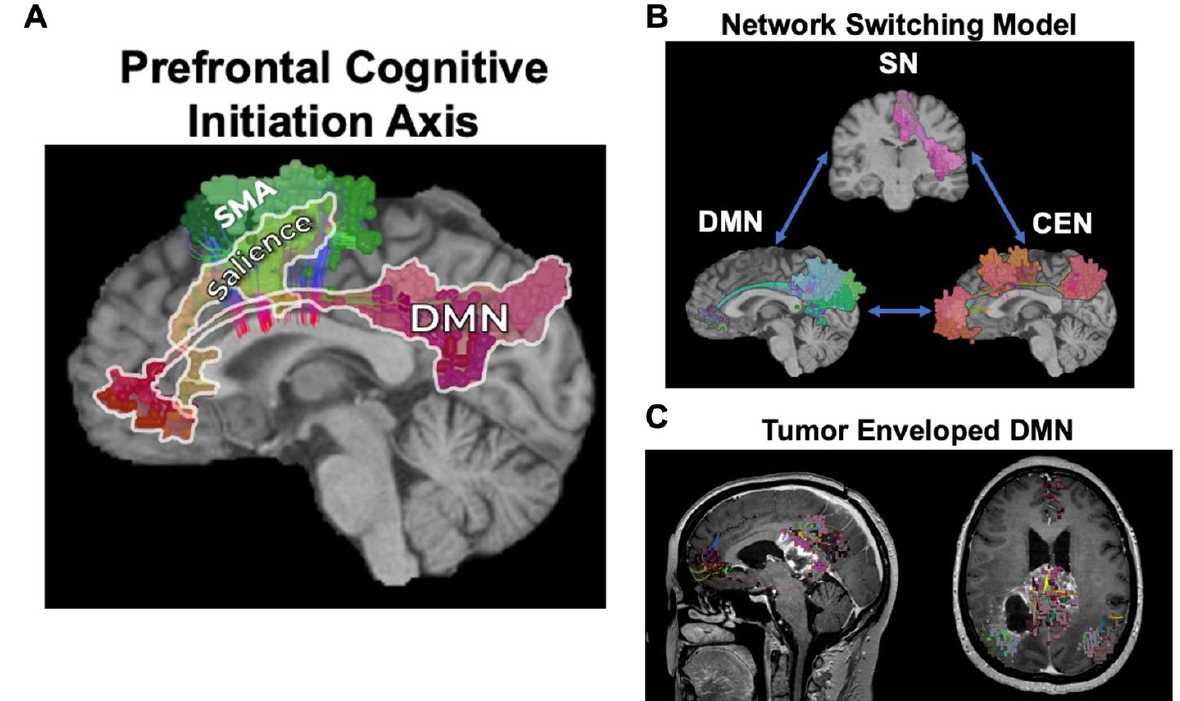
Figure 5. Prefrontal Cognitive Control Networks. ( A ) The Prefrontal Cognitive Initiation “Axis” is demonstrated where the DMN, connected via the cingulum, and the SN, connected via the frontal aslant tract, form a strip across the medial frontal lobe up until the supplementary motor area (SMA). ( B ) The network switching model, or triple network, is represented. The salience network (SN) controls the allocation of cognitive resources between internally focused (DMN) and externally focused (CEN) network functions. ( C ) A posterior butterfly glioma of the splenium is seen enveloping the DMN and demonstrates the risk of butterfly glioma surgery in this area on DMN integrity.